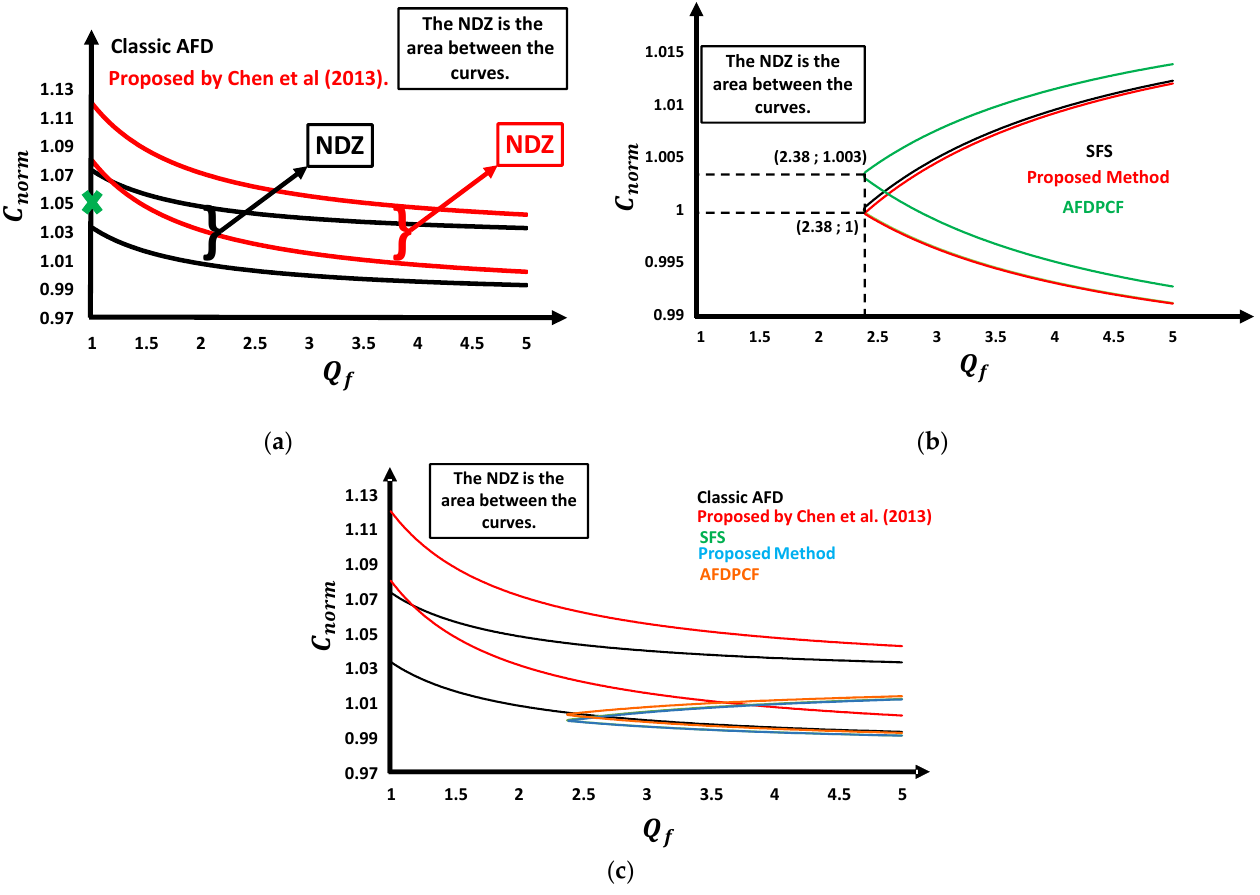
Figure 13. Demonstration of the NDZ of the methods separated by the groups: ( a ) NDZ for the method of Group I; ( b ) NDZ for the methods of the Group II; ( c ) comparison of the NDZ of all of the implemented solutions [24].